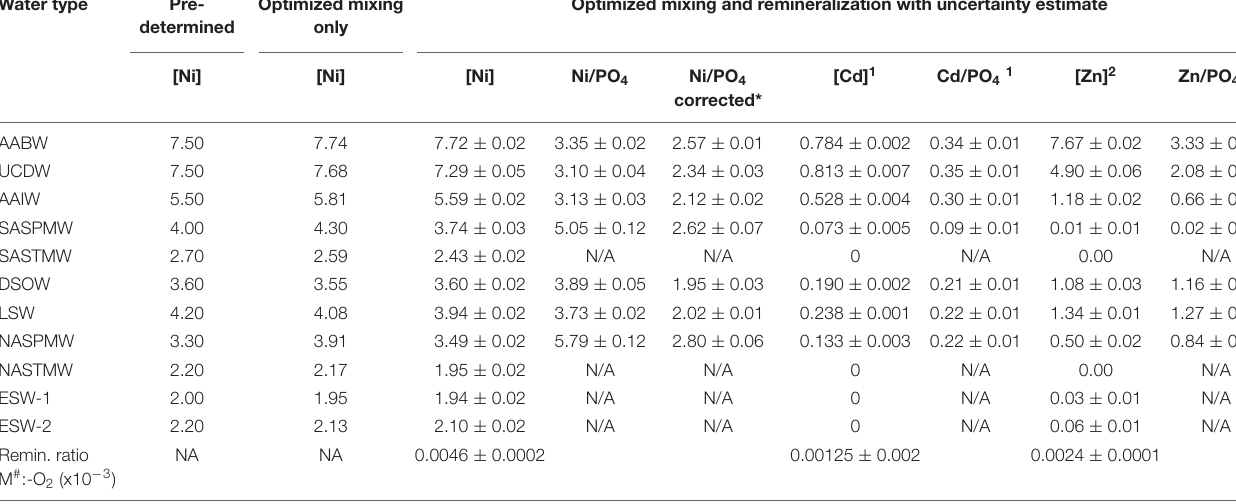
TABLE 2 | Predetermined and eOMP endmember solutions (mixing only and optimized mixing and remineralization Model) for the Ni concentration (nmol kg − 1 ) in the various water types. Additionally the calculated dissolved Ni/PO 4 , Cd/PO 4 , and Zn/PO 4 ratios are reported for the endmember water masses. Water type Pre- Optimized mixing determined